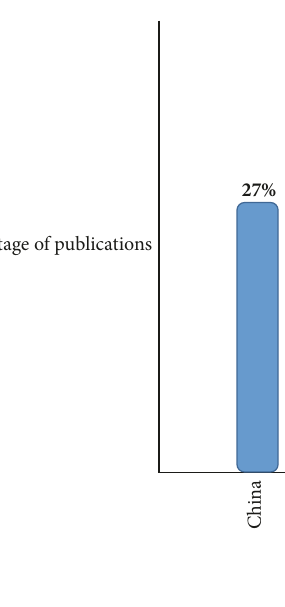
Figure 2: Site specific records of publications from the Far-Eastern Himalayan Landscape